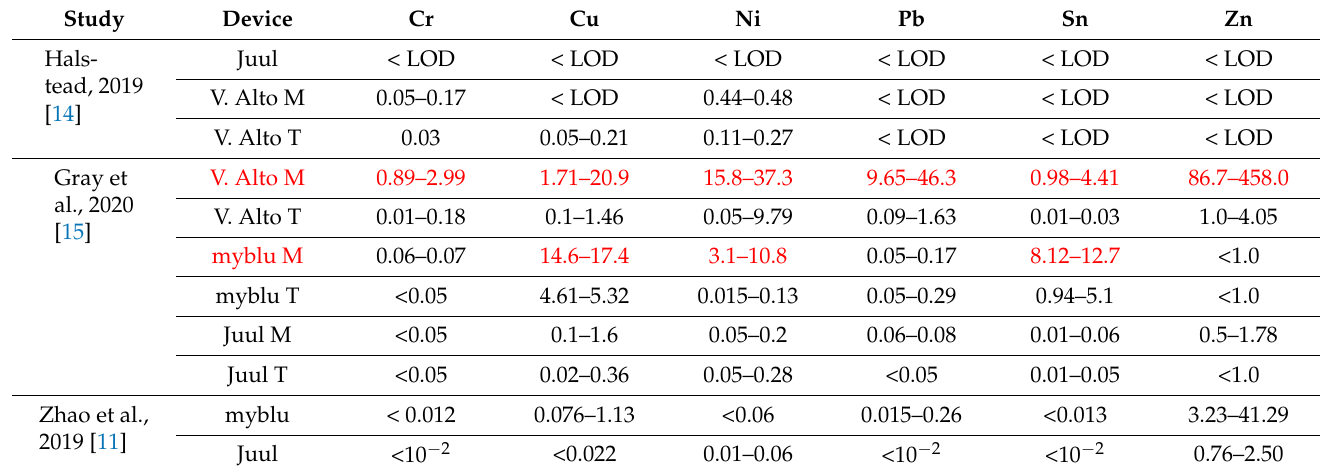
Table 8. Mass per puff for pods devices tested by the CDC group ([14,15]) and Zhao et al. [11]. The values displayed in red correspond to the testing of the Vuse Alto (V. Alto) and myblu devices with Menthol flavor. Notice that nickel, lead, manganese and zinc outputs per puff from these particular cartridges are comparable to those found in the highest power settings of sub-ohm devices tested by Zhao et al. [11] listed in Table 5, thus suggesting an anomalous